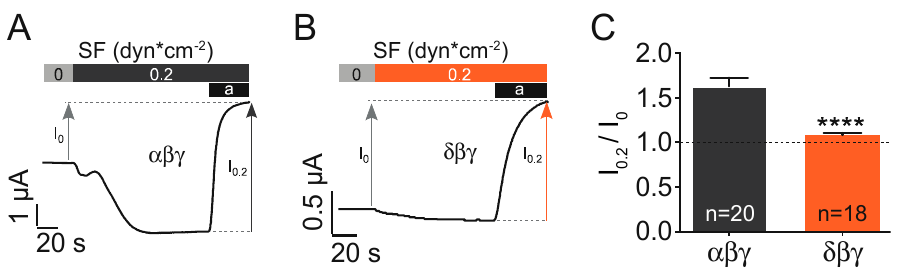
Figure 1. Shear force (SF) activation of αβγ and δβγ ENaC. Representative current traces ( A , B ) and statistics of the normalised shear force response of αβγ and δβγ ENaC ( C ). Amiloride (a) was used to determine ENaC-mediated currents in the absence (I 0 ) and presence (I 0.2 ) of shear force. The shear force response (I 0.2 /I 0 ) of δβγ was smaller compared with αβγ (****, p < 0.0001, unpaired t -test; I 0 indicated by the dashed line).